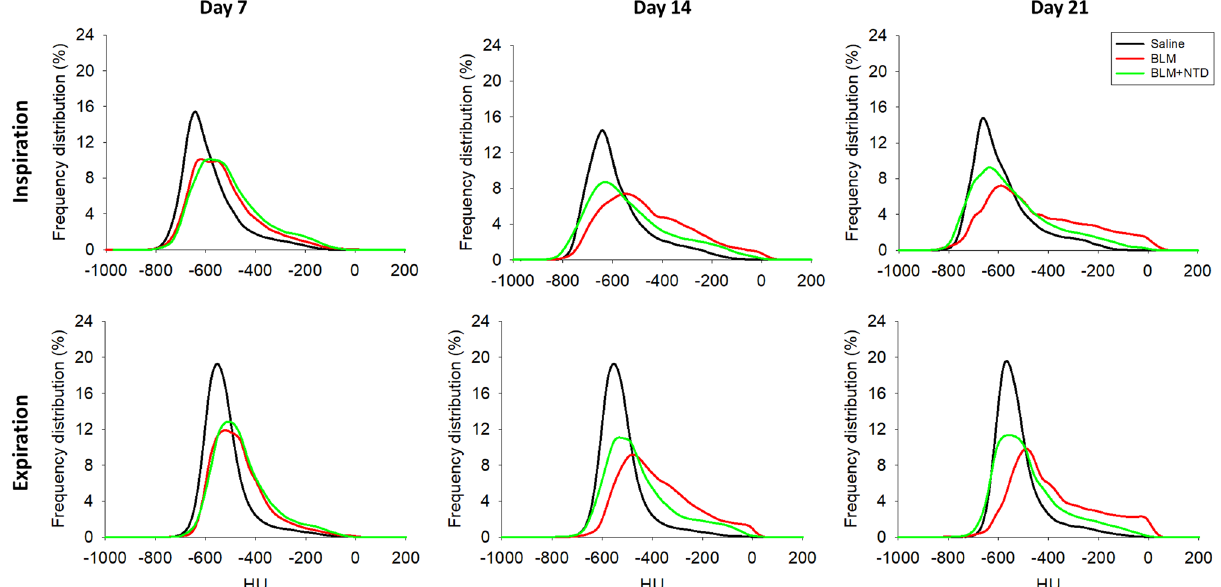
Figure 2. Median density histograms of saline (black), BLM (red) and BLM + NTD (green) groups in inspiration (top row) and expiration (bottom row) at all timepoints. The histograms showed a progressive shift of the peak to the right starting from day 7 and a thickening of the right-side tail from day 14 for both the BLM and the Nintedanib-treated groups compared to the saline. At day 21, these changes progressed only in the BLM group.